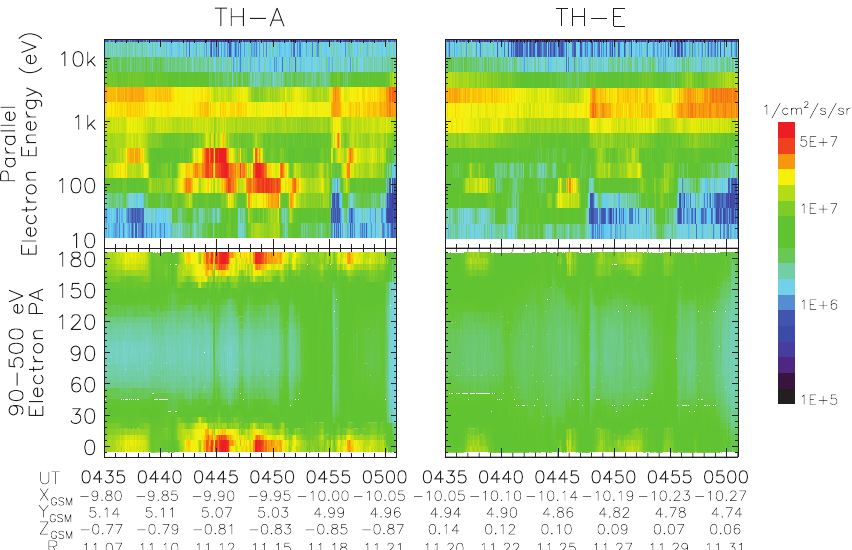
Fig. 12. Top panels show the electron energy flux spectrogram in parallel direction for TH-A (left side) and TH-E (right side) during the second arc activation interval. The bottom panels show the pitch-angel spectrogram of 90–500eV electrons for TH-A and TH-E.